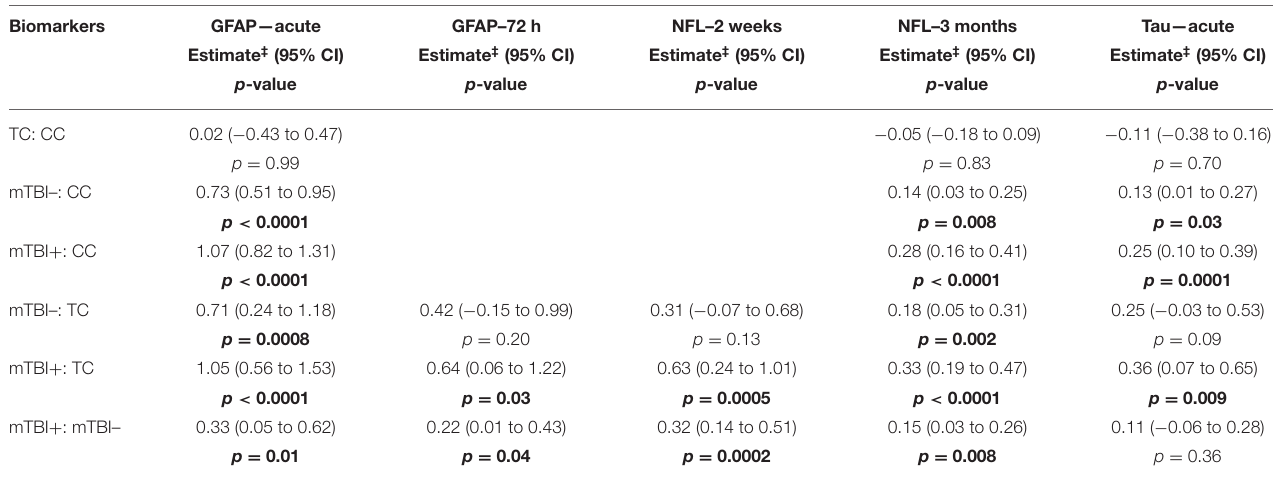
TABLE 5 | Results from Tukey HSD comparisons for biomarkers at designated timepoints between patients with mTBI without somatic injuries (mTBI–), patients with mTBI with somatic injuries (mTBI + ), trauma controls (TC), and community controls (CC).